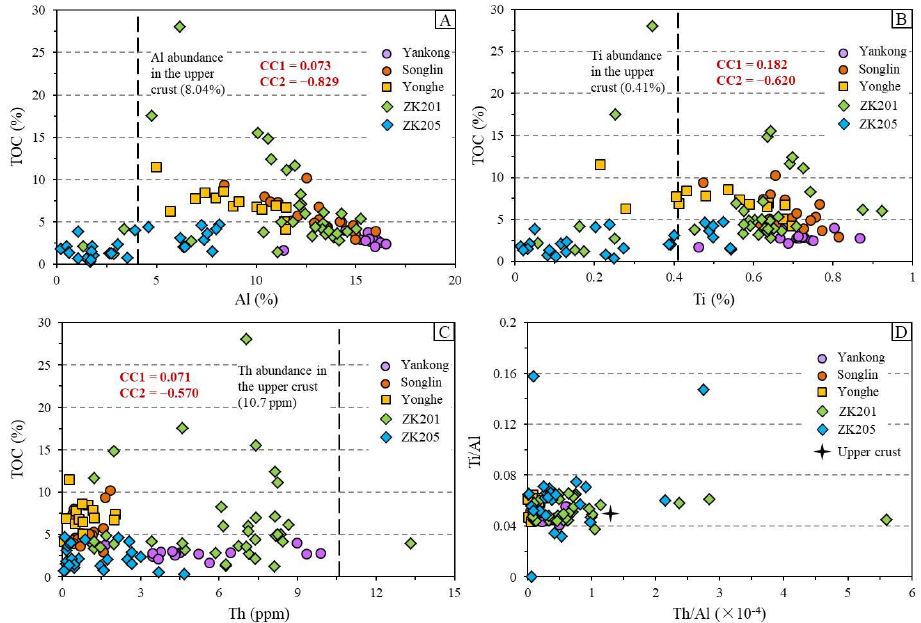
Figure 7. Plots of TOC versus ( A ) Al, ( B ) Ti, and ( C ) Th, and ( D ) plot of Ti/Al versus Th/Al. CC1 — correlation coefficient of each element concentration and TOC content of all the black shales (including Yankong, Songlin, and Yonghe sections and wells ZK102 and ZK205); CC2 — correlation coefficient of each element concentration and TOC content of black shales from the intra-platform basin (including Yankong, Songlin, and Yonghe sections).